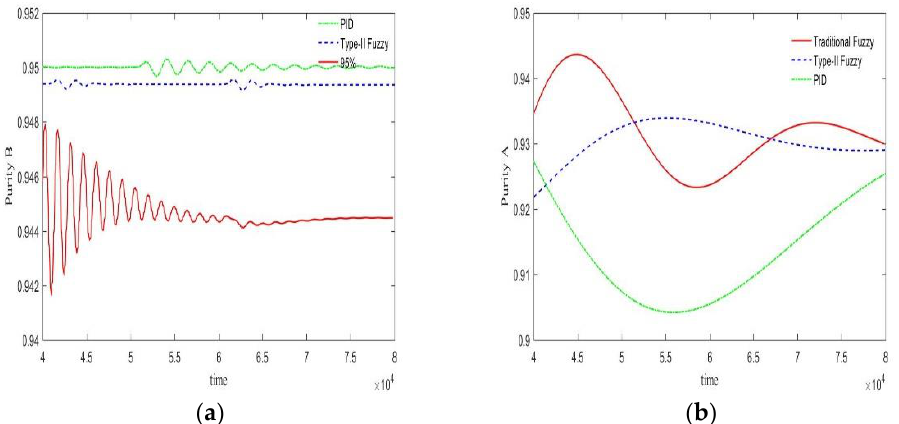
Figure 11. The control results of the three controllers (switch time = 180 s; desired A = 93%, desired B = 95%). ( a ) Extraction outlet (material B); ( b ) raffinate outlet (material A).